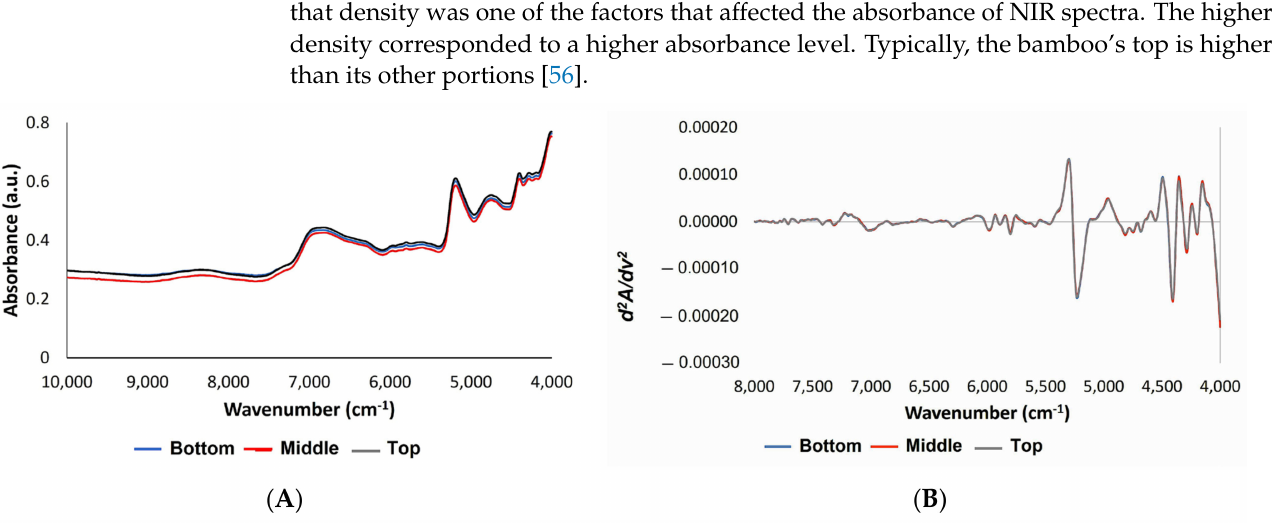
Figure 13. The original spectra of NIR at the wavenumber 10,000–4000 cm − 1 ( A ); second derivative spectra at the wavenumber 8000–4000 cm − 1 ( B